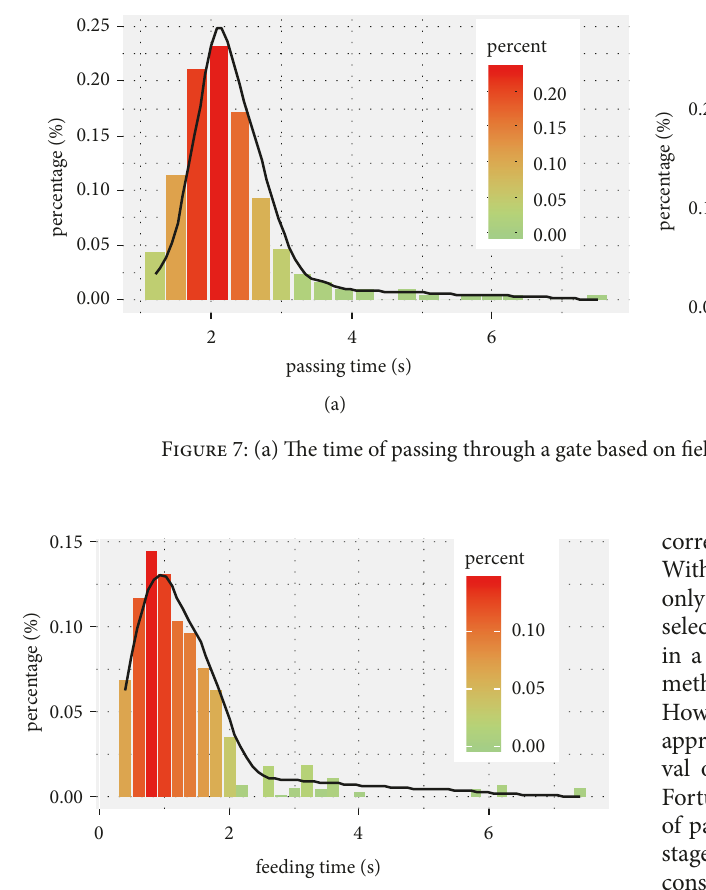
Figure 8: The feeding time based on field